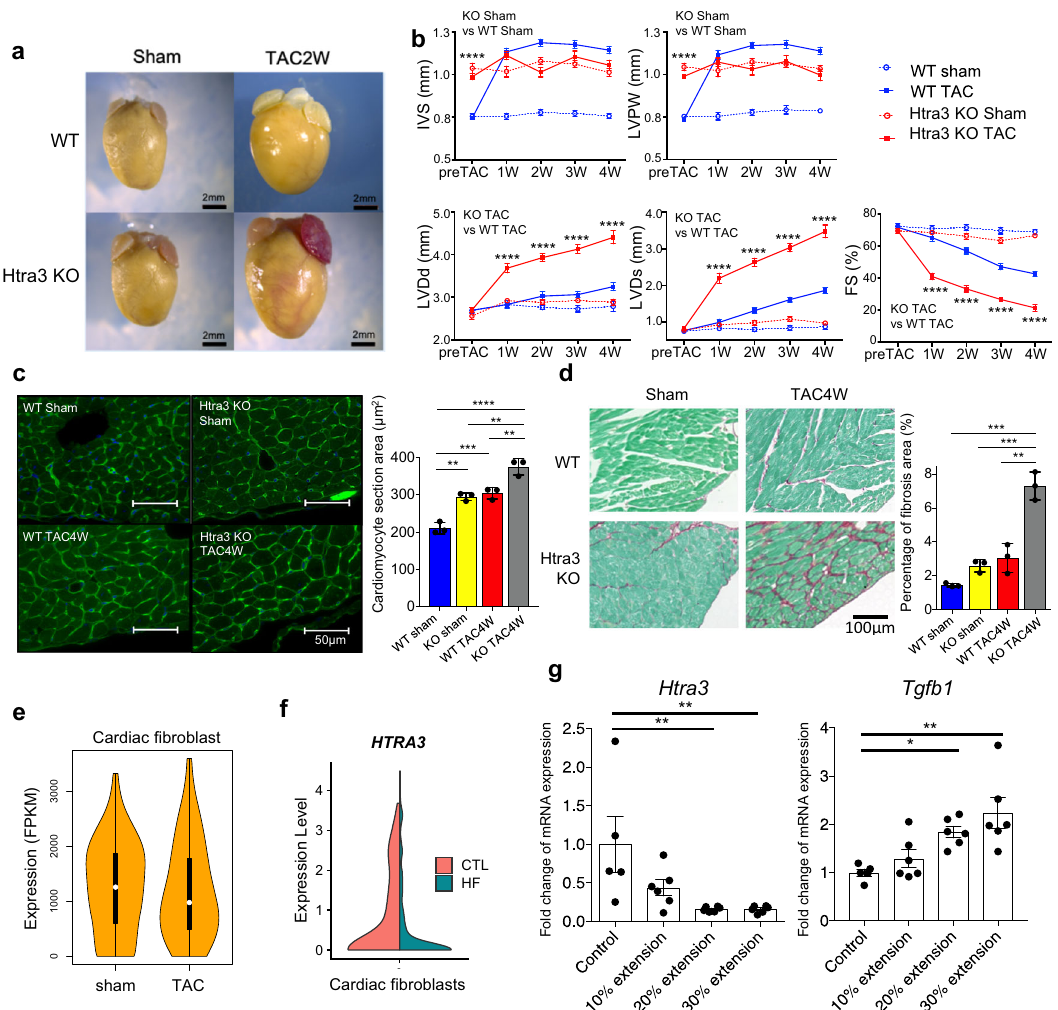
Fig. 2 Htra3 KO mice shows cardiac and cardiomyocyte hypertrophy and are vulnerable to mechanical stress. a Representative cardiac morphology of WT and Htra3 KO mice at 2 weeks after TAC or sham surgery. b Echocardiographic assessment of the heart of WT and Htra3 KO mice after TAC or sham surgery. n = 11 (WT Sham), n = 15 (WT TAC), n = 10 (Htra3 KO Sham), n = 15 (Htra3 KO TAC). Data are shown as mean and SD. * P < 0.05, ** P < 0.01, *** P < 0.005, **** P < 0.001; signi fi cance was determined by two-way analysis of variance (ANOVA) with Bonferroni ’ s multiple comparison test. Source data are provided as a Source Data fi le. c , Assessment of cardiomyocyte section area. WGA and DAPI are used to stain the plasma membrane and nucleus, respectively. Results of quantitative analysis are also shown. Averaged data from about 40 – 100 cells per heart ( n = 3 each). Data are shown as mean and SD. ** P < 0.01, *** P < 0.005, **** P < 0.001; signi fi cance was determined by one-way ANOVA with Tukey ’ s or Dunnett ’ s post hoc test. Source data are provided as a Source Data fi le. d Histochemical detection of collagen fi bers by Sirius Red/Fast Green dye staining in WT and Htra3 KO mice after TAC or sham surgery. Results of quantitative analysis of fi brosis area are also shown ( n = 3 each). Data are shown as mean and SD. * P < 0.05, ** P < 0.01, *** P < 0.005, **** P < 0.001; signi fi cance was determined by two-way ANOVA with Tukey ’ s or Dunnett ’ s post hoc test. Source data are provided as a Source Data fi le. e Violin plot showing Htra3 RNA expression in cardiac fi broblasts at 2 weeks after TAC ( n = 40) and sham surgery ( n = 109) in WT mice. Data represent box plots and individual data points. Box plots show the median (center line), fi rst and third quartiles (box edges), while the whiskers going from each quartile to the minimum or maximum. f Violin plot showing the HTRA3 expression levels ( n = 143 cells from control subjects (CTL), n = 151 cells for patients with heart failure (HF)). g mRNA expression levels of Htra3 and Tgfb1 in cultured cardiac fi broblasts after the 0~30% mechanical extension were assessed by real-time qPCR ( n = 5, 6, 6, 6 at each group, respectively). Data are shown as mean and SD. * P < 0.05, ** P < 0.01; Signi fi cance was determined by one-way analysis of variance (ANOVA) with Bonferroni ’ s multiple comparison test. Source data are provided as a Source Data fi le.